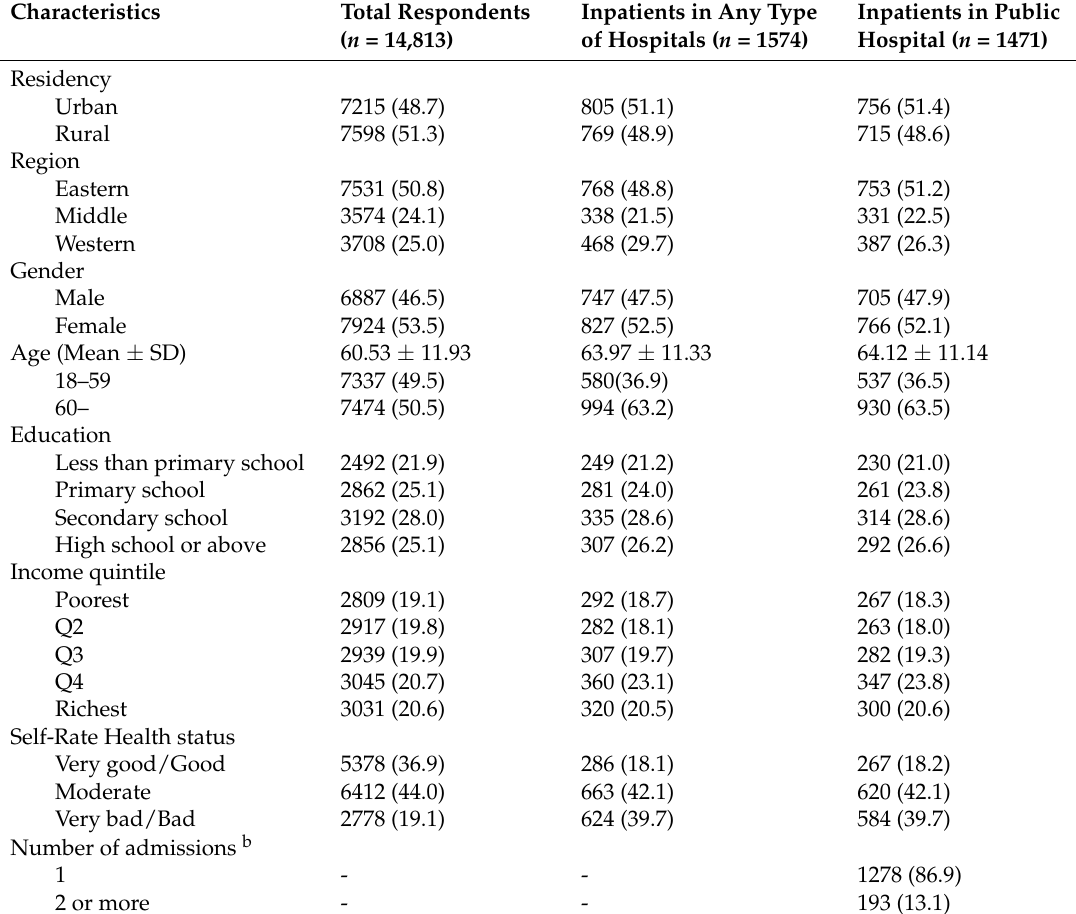
Table 1. Characteristics of total respondents and inpatients discharged from public hospitals n (%) a